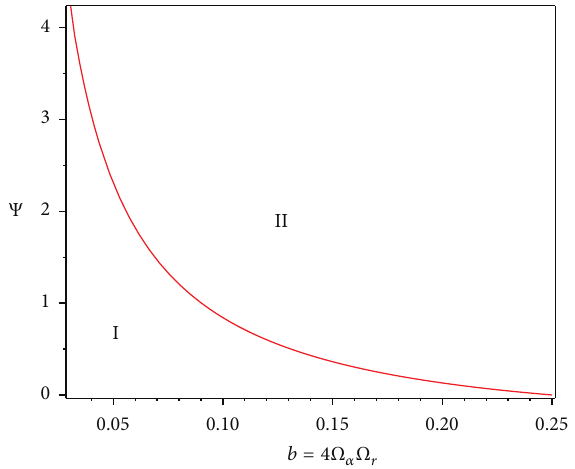
Figure1:Theupperregion(region II)ofthisfigureiscorresponding ,𝑤 ) that fulfils inequality (28). to the set (Ω 𝑟 , Ω 𝛼 , Ω curv curv